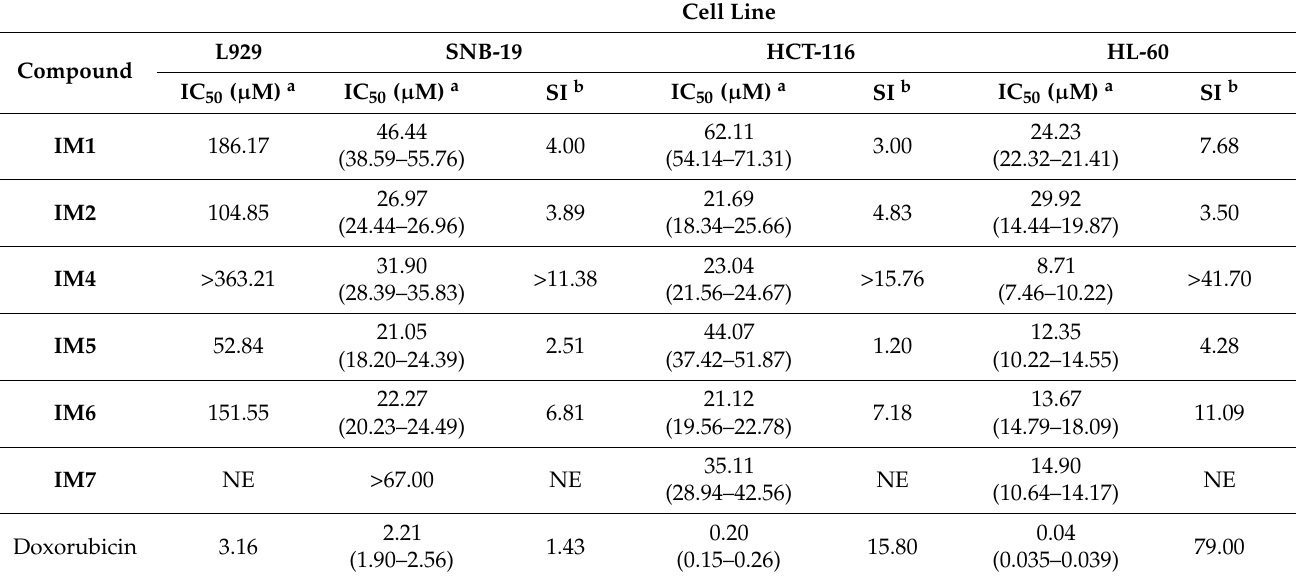
Table 2. Cytotoxic activity of IM1 , IM2 , IM4 , IM5 , IM6 , and IM7 after a 72 h exposure expressed by IC 50 ( µ M) and confidence